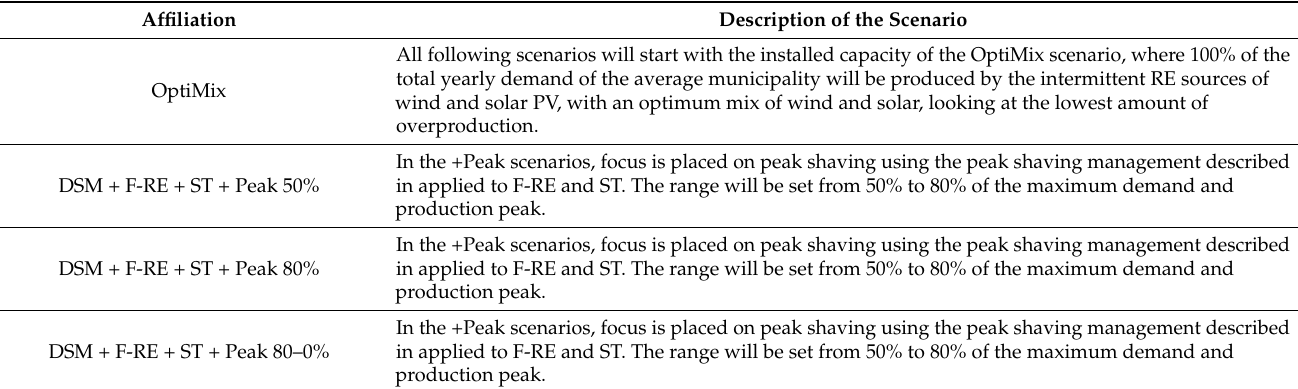
Figure A8. The principle of peak shaving in the PowerPlan model. Table A14. Peak shaving scenarios.